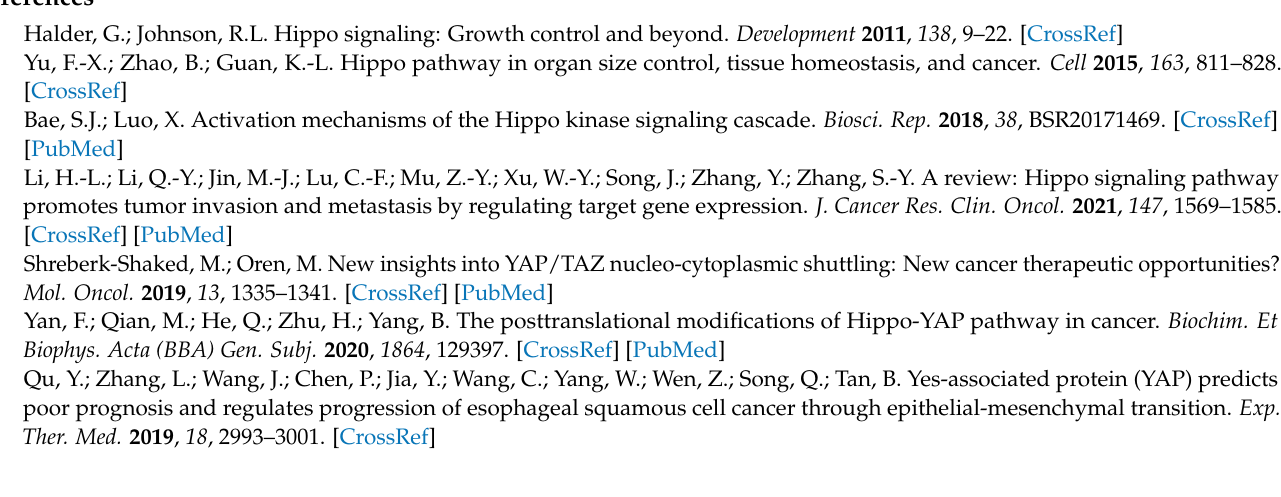
S2: NF- κ B signaling regulates ZO-1 expression and cell migration. Figure S3: YAP and ZO-1 expression is regulated reciprocally. Figure S4: AMOT is associated with YAP and ZO-1. Figure S5: Regulation of AMOT expression in ZO-1 KD or YAP KD cells. Figure S6. Analysis of relationship between cell proliferation and cell island area expansion in AGS and EC96. Table S1: The sequences of siRNAs. Table S2: Primer sequences of